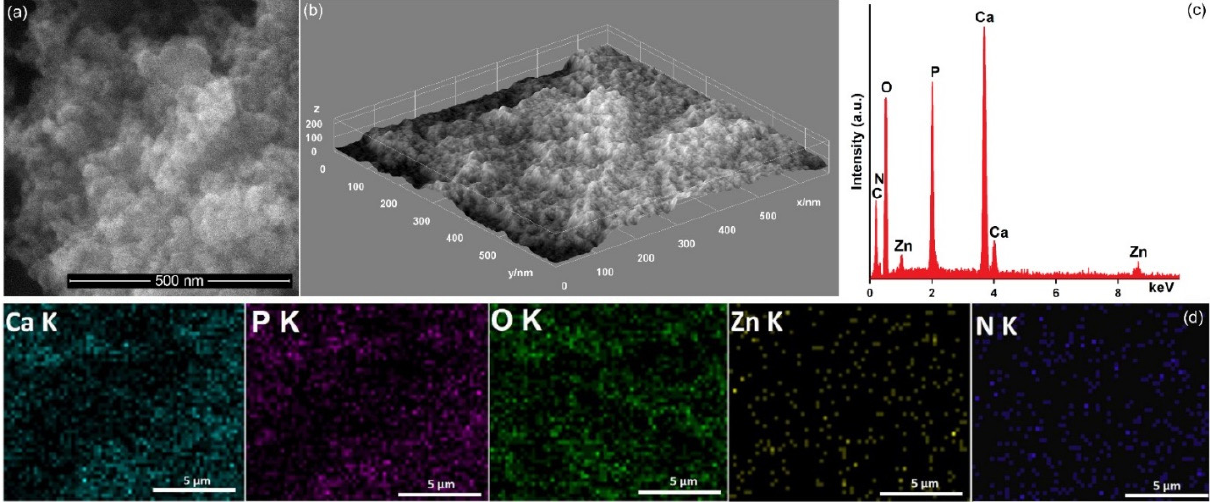
Figure 2. SEM micrographs in 2D and 3D obtained for ZnHApC powders ( a , b ). EDX spectra ( c ) and elemental distribution maps ZnHApC powders ( d ).